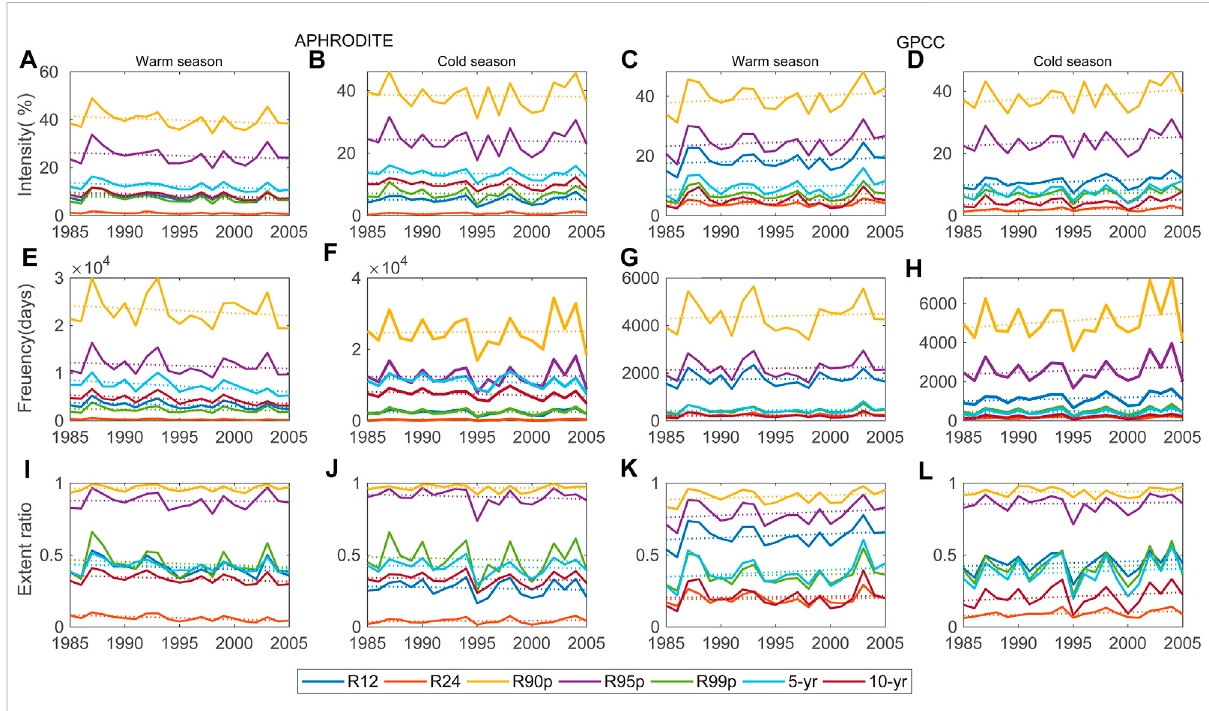
FIGURE 9 Thevariation(solidline)andtrend(dottedline)ofintensity (A – D) ,frequency (E – H) ,andextent (I – L) ofextremeprecipitationbyseventhreshold criteria based on APHRODITE and GPCC datasets over Central Asia from 1985 to